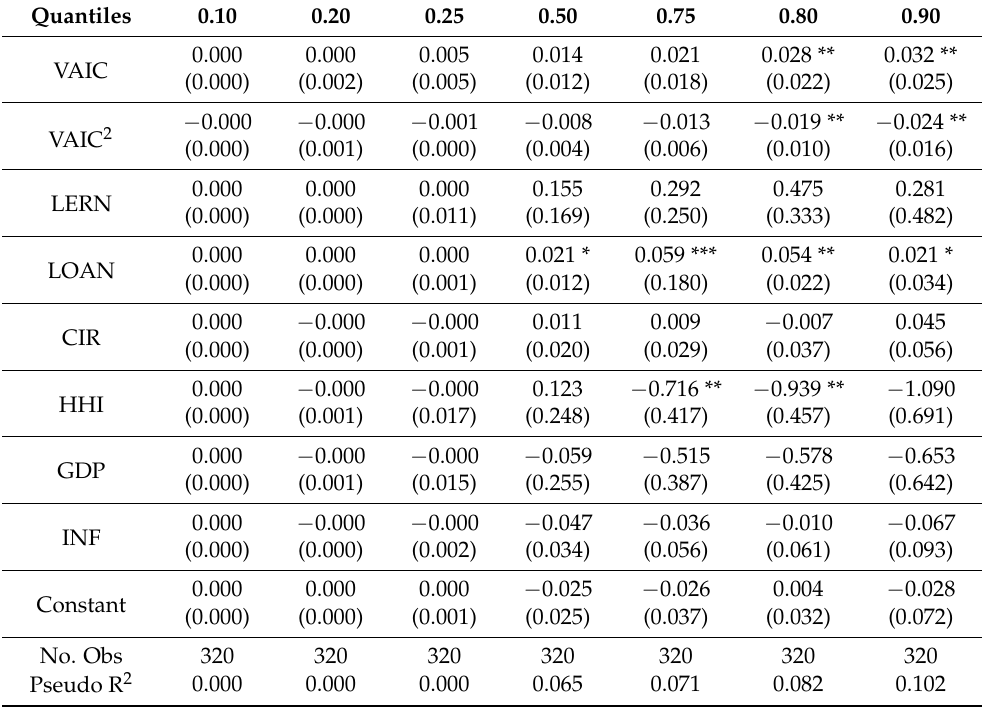
Table 4. Baseline results for Z and VAIC : Quantile